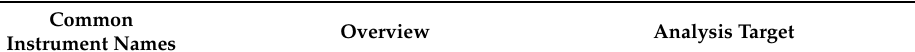
Table 1. Characteristics of typical mass spectrometry